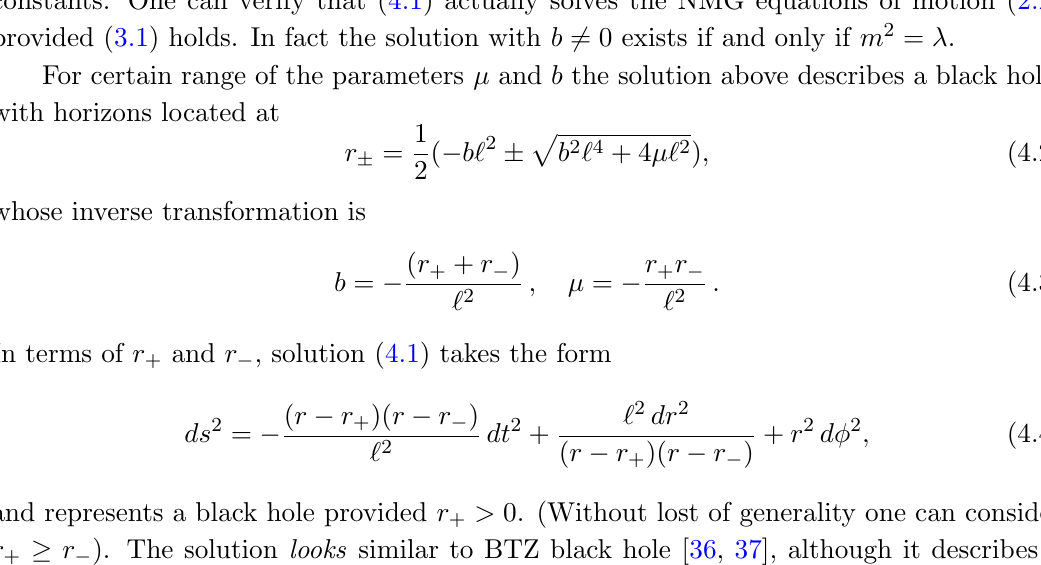
, and where (cid:22) and b are two > 0